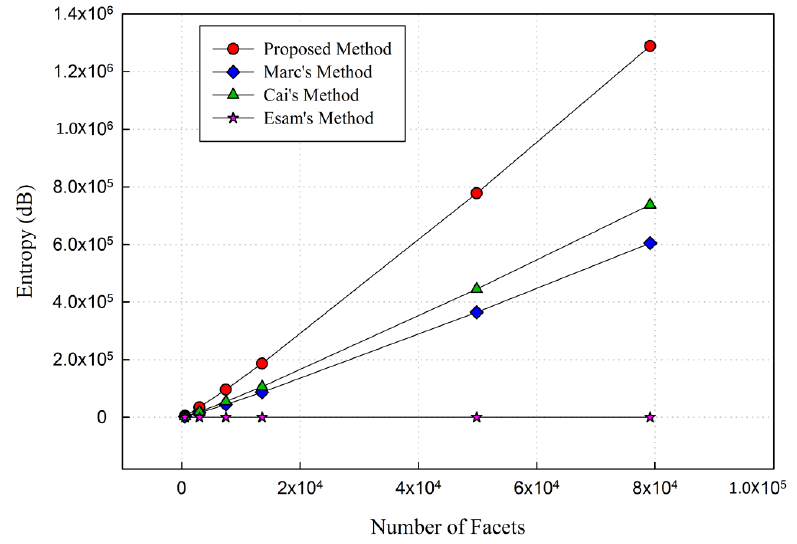
Figure 7. Entropy of the proposed method.